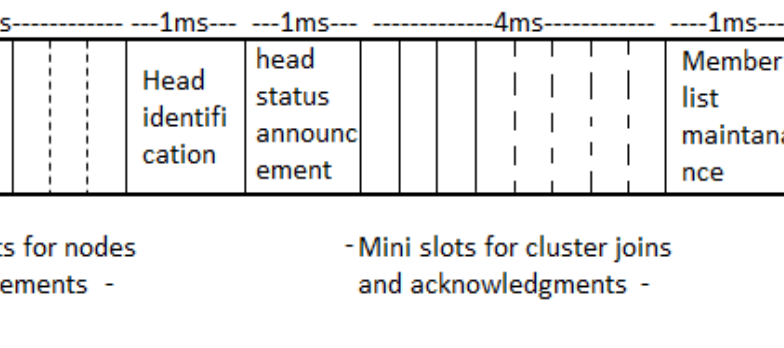
Figure 3. Cluster